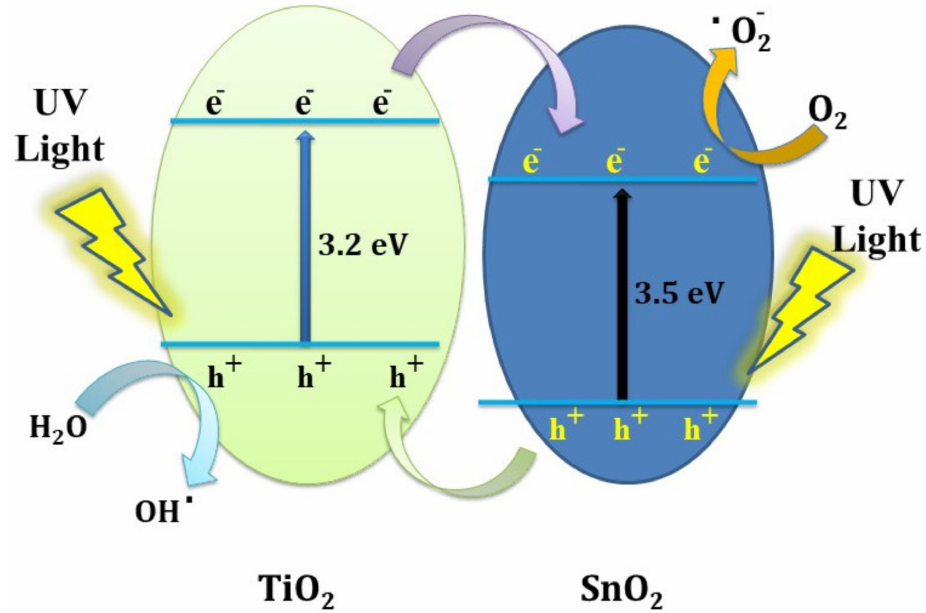
Scheme 1. Schematic representation illustrating the charge-transfer pathway of TiO 2 /SnO 2 (TSU80) nanocomposite for MO degradation under UV light